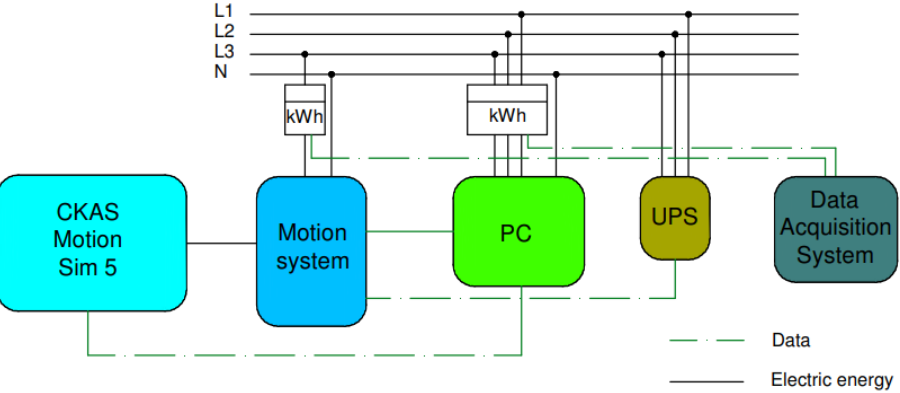
Figure 4. Electric energy measurement system used in tests on the CKAS Motion Sim 5 simulator.